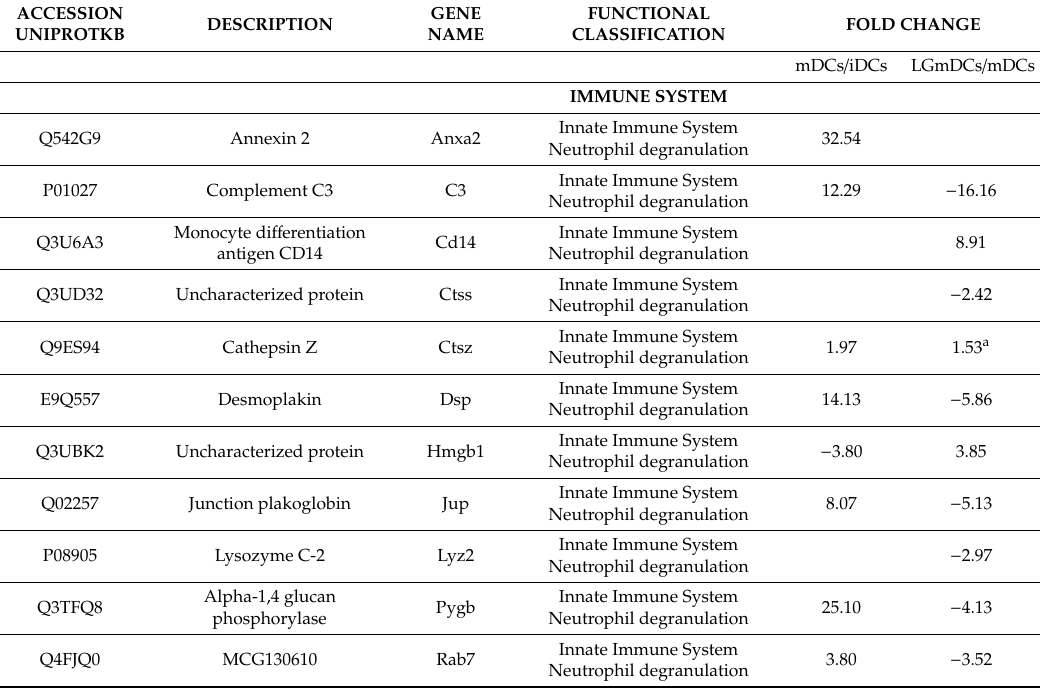
Table 1. Results of the di ff erential proteomic study: proteins whose abundance was a ff ected by the maturation process of DCs challenged or not with L. gasseri and functional classification obtained by the Reactome Pathway